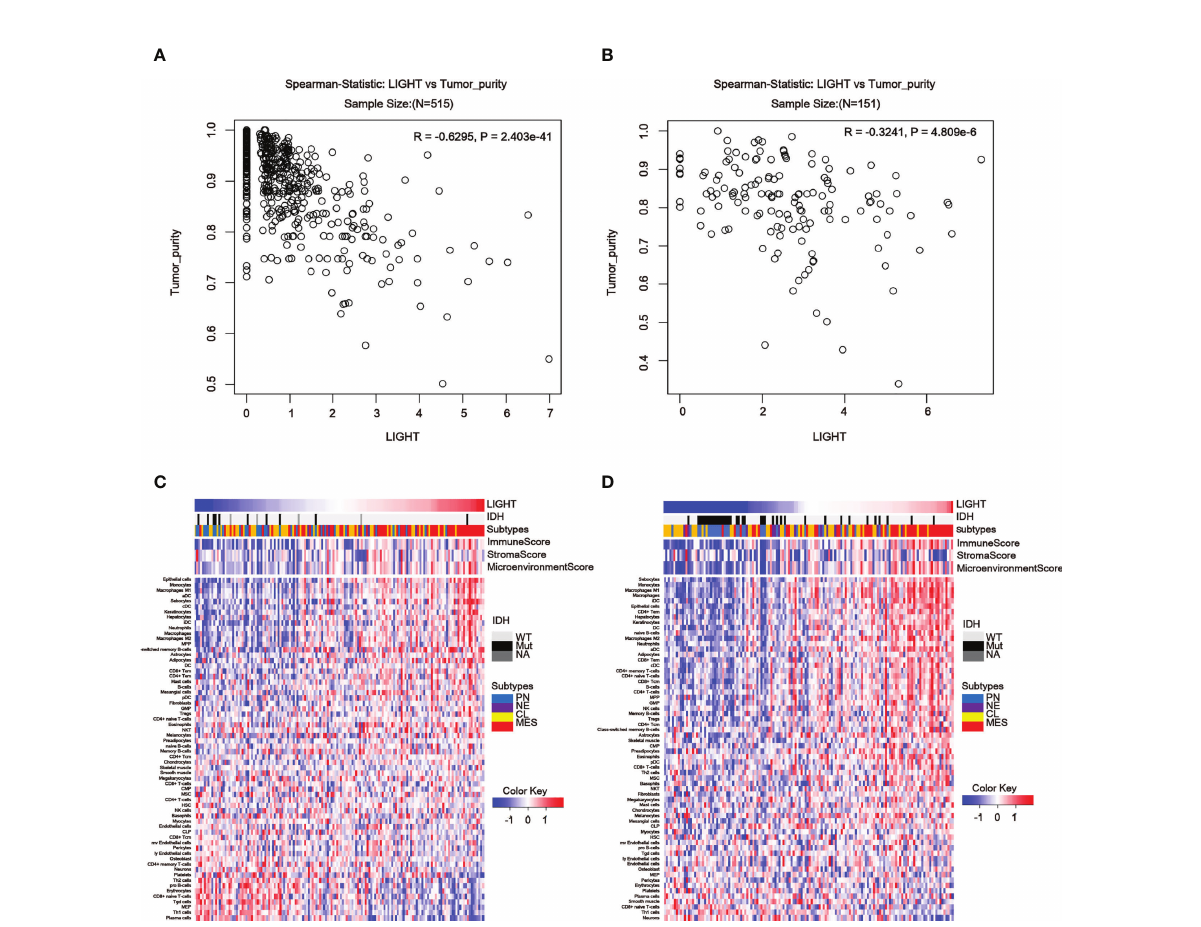
FIGURE 6 LIGHT in the tumor microenvironment is associated with tumor purity and immune or stromal cell populations. (A, B) In the TCGA (A) and CGGA datasets, LIGHT expression is negatively linked with tumor purity (B) . Heatmaps using TCGA (C) and CGGA GBM data in (C, D) show the relationship between LIGHT and 64 immune or stromal cell types (D)